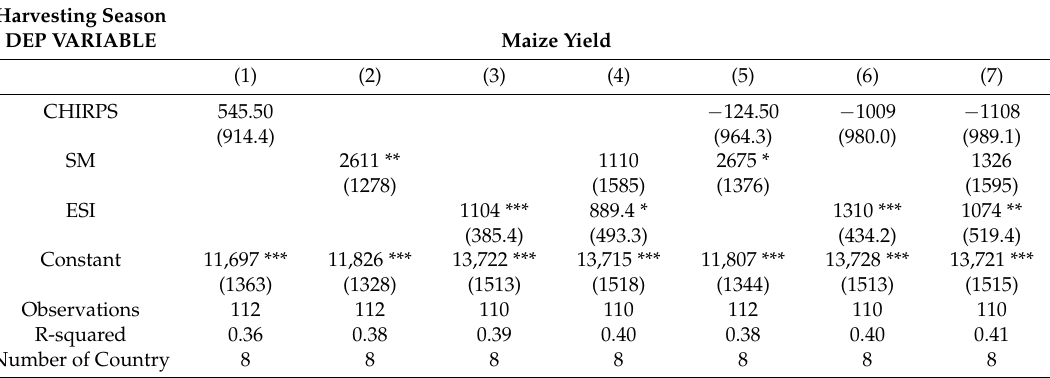
Table 5. Results of the simple linear regression with fixed effects focusing on maize-harvesting months for standardized anomalies of rainfall (Column 1), soil moisture (Column 2), ESI (Column 3), soil moisture and ESI (Column 4), rainfall and soil moisture (Column 5), rainfall and ESI (Column 6) and all variables combined (Column 7); annual maize yield is the dependent variable; rows represent the regression coefficient for the three independent variables (rainfall, soil moisture, ESI), the regression constant, the number of observations, the R-squared, and the number of countries (8); asterisks mark statistically significant results.